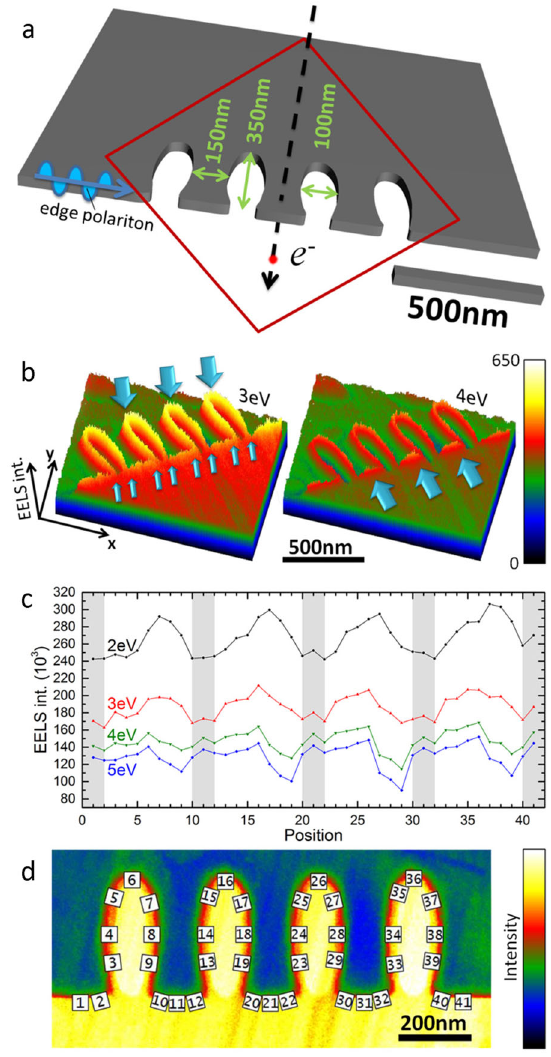
Fig. 3 Energy- fi ltered TEM images of the fi nite grating structure at a Bi 2 Se 3 edge. a Schematic of the fi nite grating structure, consisting of round-shaped grooves. The investigated area is marked by a red frame. b EFTEM images at different energy-losses (3 and 4 eV) acquired with an energy window of 0.2 eV width. The intensity variation indicates the relative local absorption probability. Big and small blue arrows point towards intensity maxima and minima, respectively, which are referred to in the main text. c Intensity modulation along the structured edge for different energy-loss values as indicated within the fi gure. The analyzed spectra were extracted from positions marked in ( d ) with numbers and averaged spatially over an area of 10 × 10 pixels. Gray shaded areas in ( c ) emphasize the positions of the bridges between